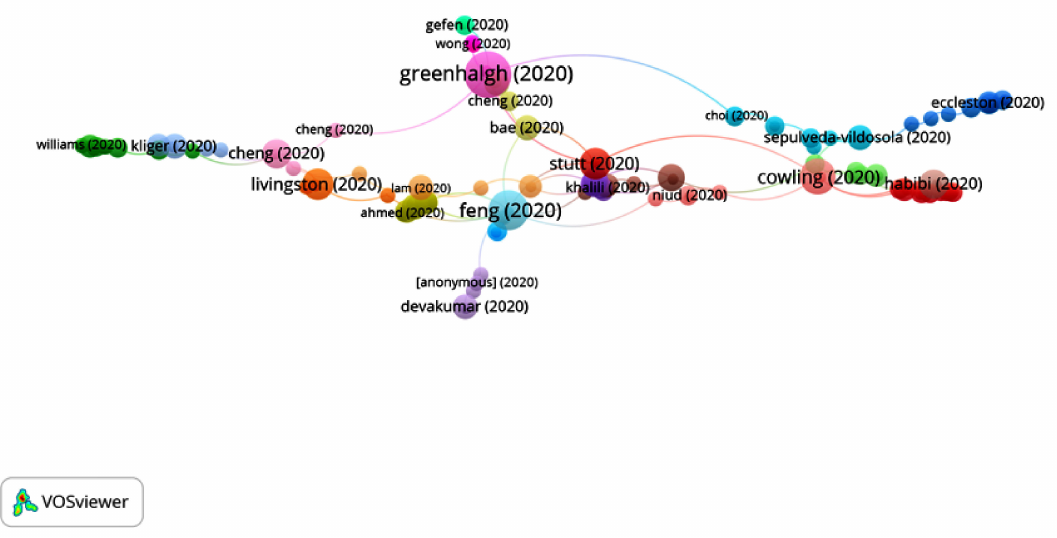
Figure 15. Citation network for Group 9.